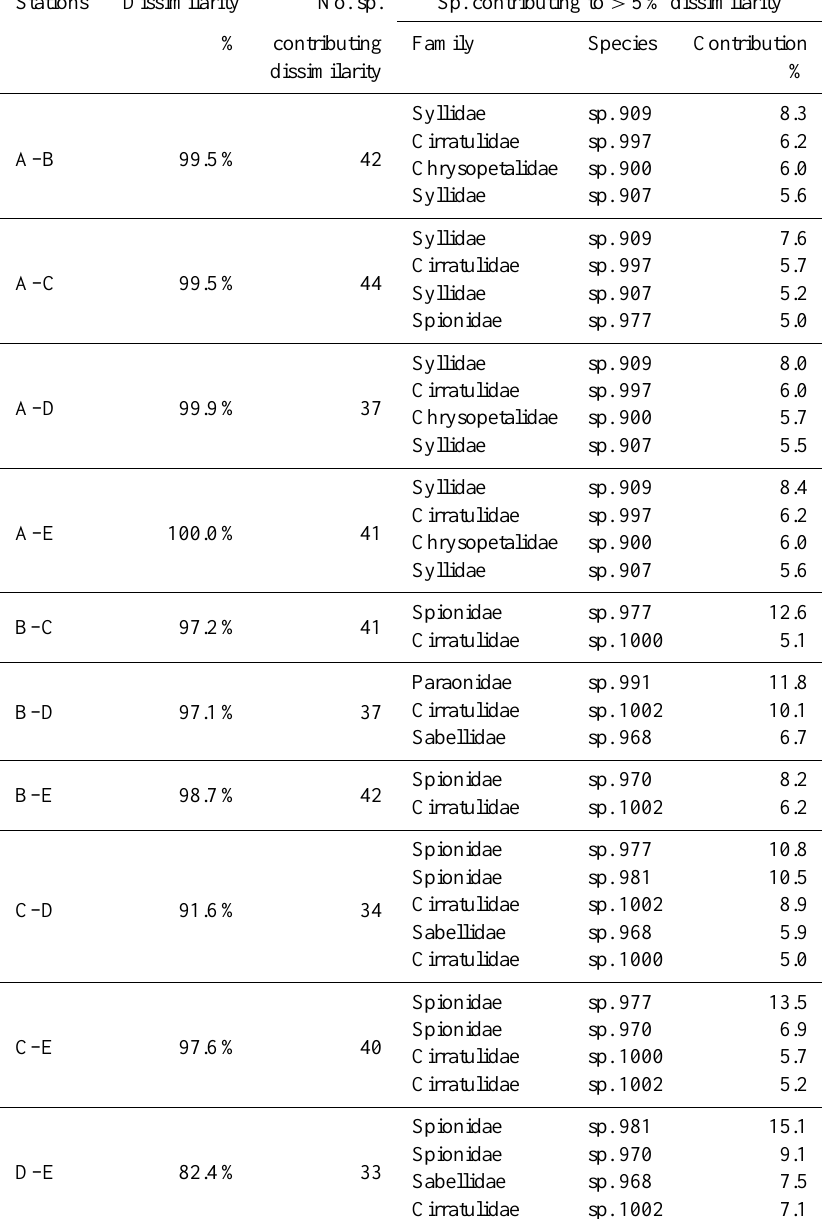
Table 4. Cluster dissimilarity percentages as identified by similarity percentages (SIMPER). The number of species contributing to total dissimilarity between stations. Species contributing to > 5% dissimilarity